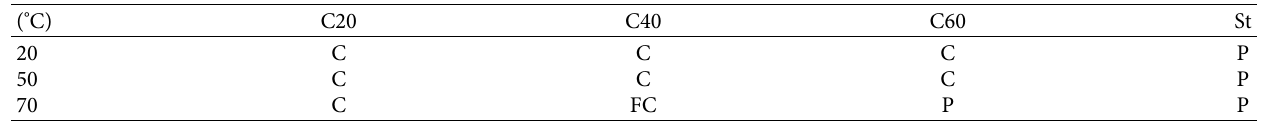
Table 4: Damage forms of samples.